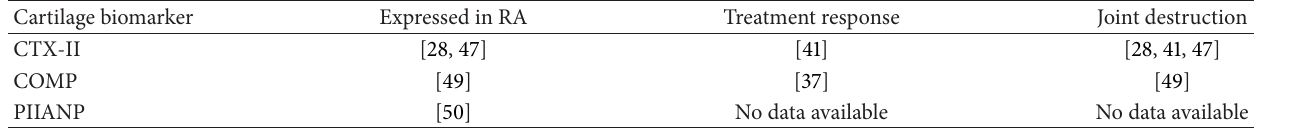
Table 2: More studied cartilage biomarkers and their interests in RA management. Cartilage